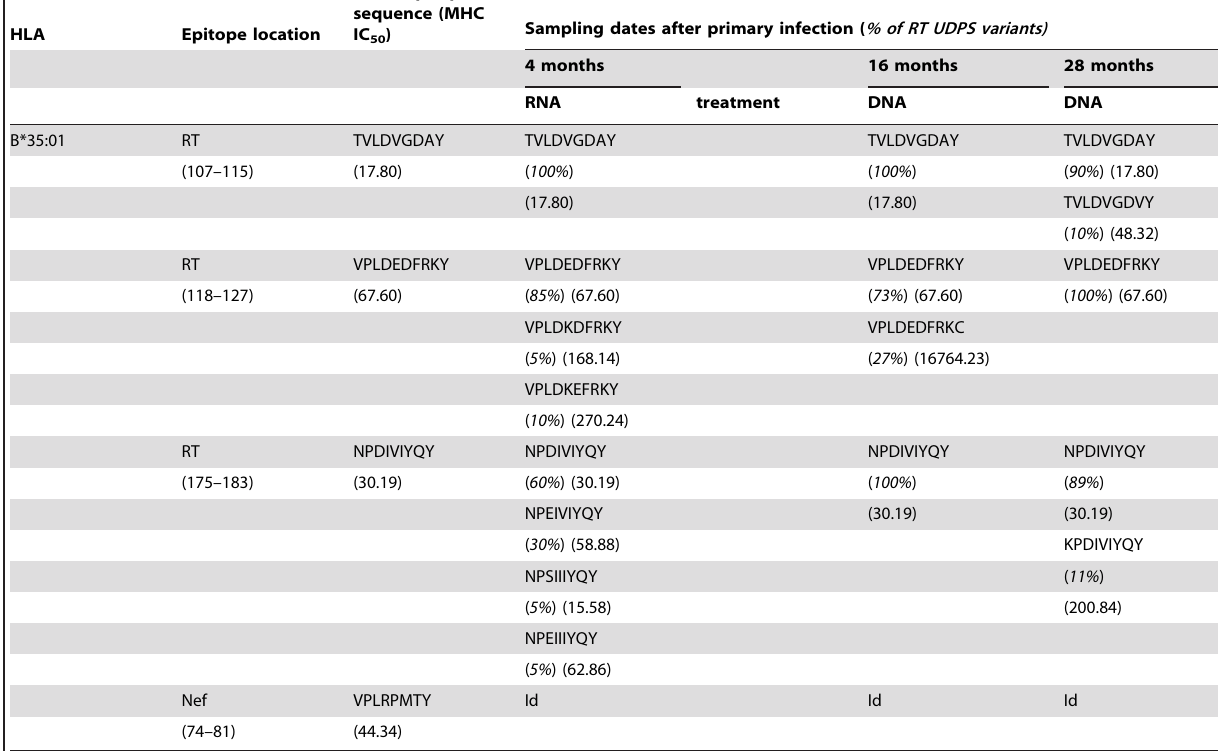
Table 5. Patient HTM